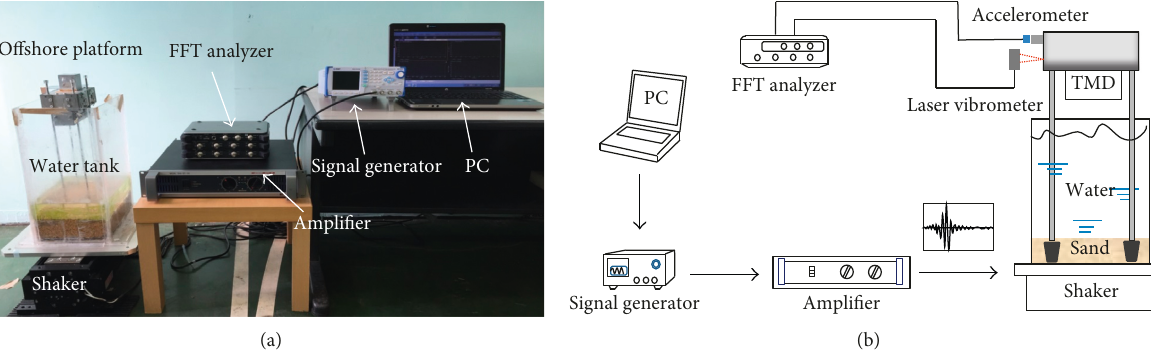
Figure 10: Diagram of the experimental system (PC: personal computer, TMD: tuned mass damper, and FFT Analyzer: fast Fourier transform analyzer). (a) Diagram of the experimental setting; (b) flowchart of the experiment